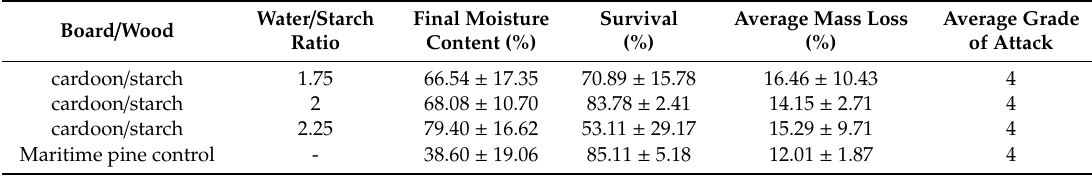
Table 2. Average results of survival, mass loss (% of initial dry mass), final moisture content and grade of attack (from 0-no attack, to 4-heavy attack) of particleboards exposed to R. grassei ( n = 3). All adhesive formulations had a starch / cardoon ratio of 0.8 and cs / starch ratio of